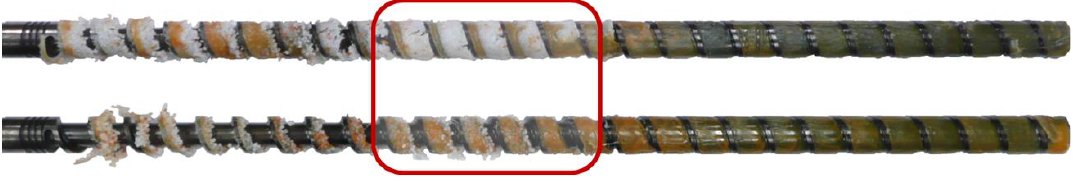
Figure 4. Polymer flow in the flood fed/starve fed single screw extrusion [8].